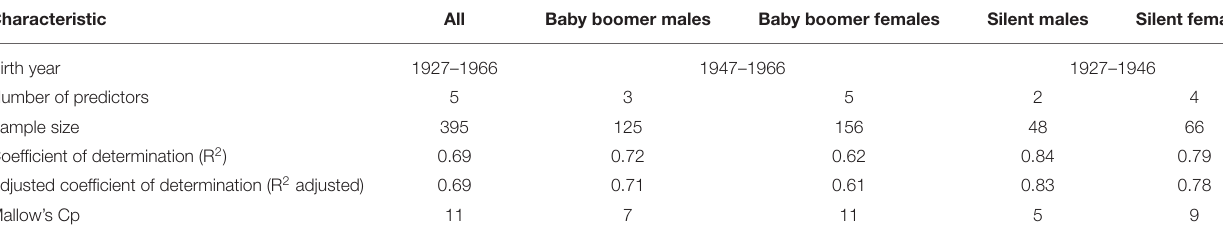
TABLE 3 | Characteristics of the